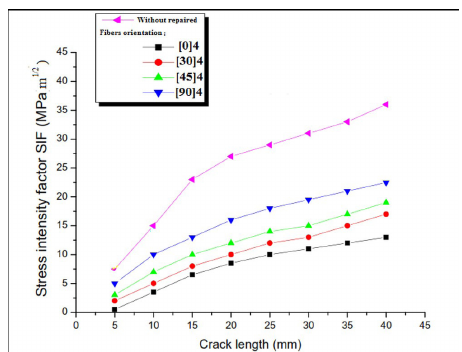
Figure 12. Stress intensity factor variation KIC (MPa.m 1⁄2 ) as a function of the fibers orientation according to crack length a